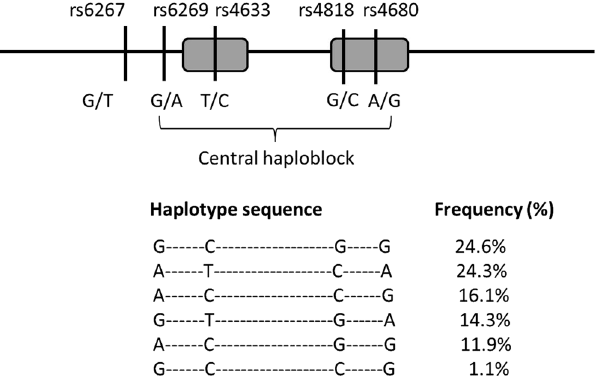
Figure 2. Schematic diagram of COMT genomic organization, SNP positions and percentage distribution of COMT haplotypes. The sequence of alleles in each haplotype for central haploblock of COMT gene reflects the order of occurrence from 5 ′ to 3 ′ in the COMT gene (SNPs: rs6269, rs4633, rs4818 and rs4680,